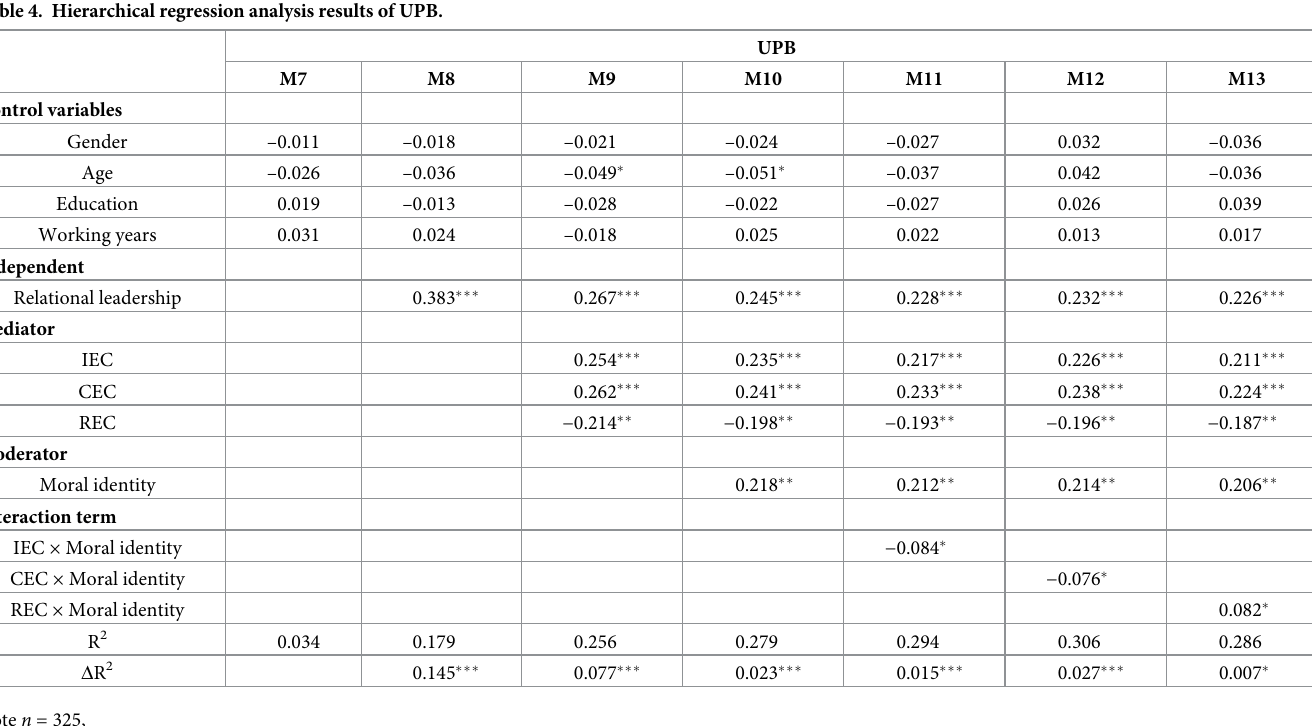
Table 4. Hierarchical regression analysis results of